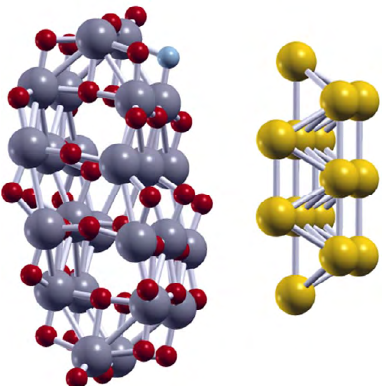
Fig. 2. Optimized geometries of two types of N-doped TiO nanocomposites. The light yellow, dark yellow, gray, red, cyan and blue balls denote sulfur, gold, titanium, oxygen, hydrogen and nitrogen atoms, respectively.